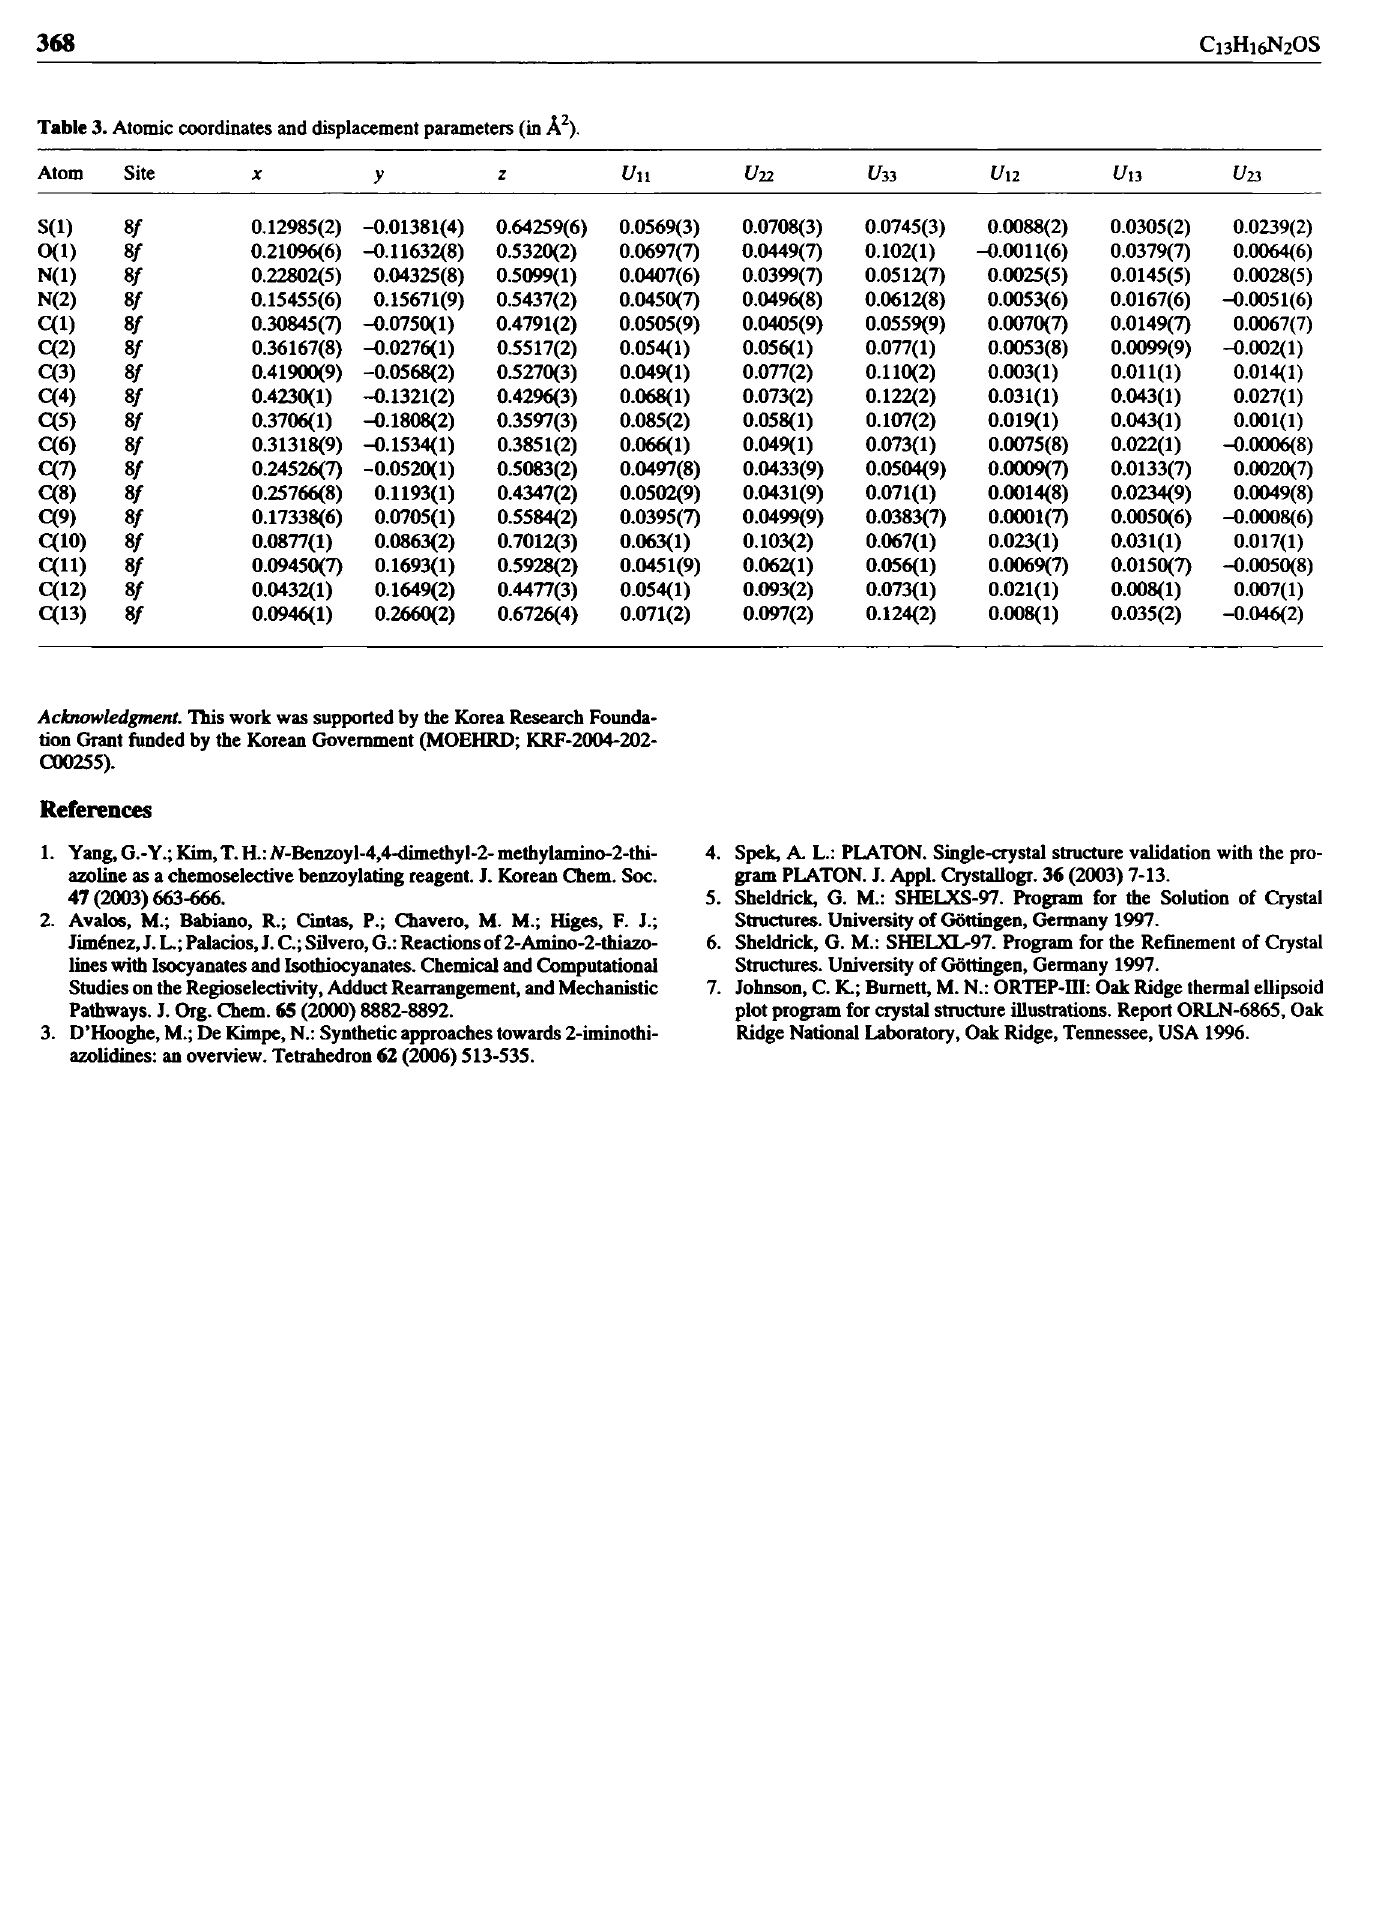
Table 3. Atomic coordinates and displacement parameters (in A 2